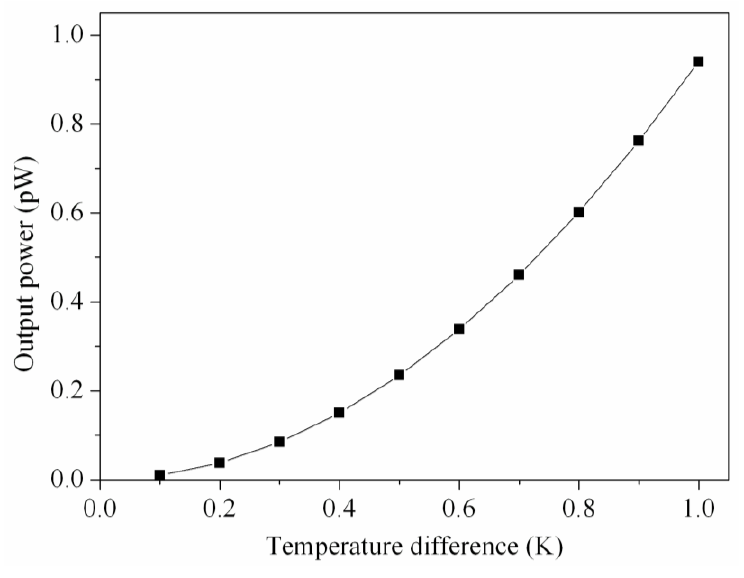
Figure 5. Simulated results of the output power for the